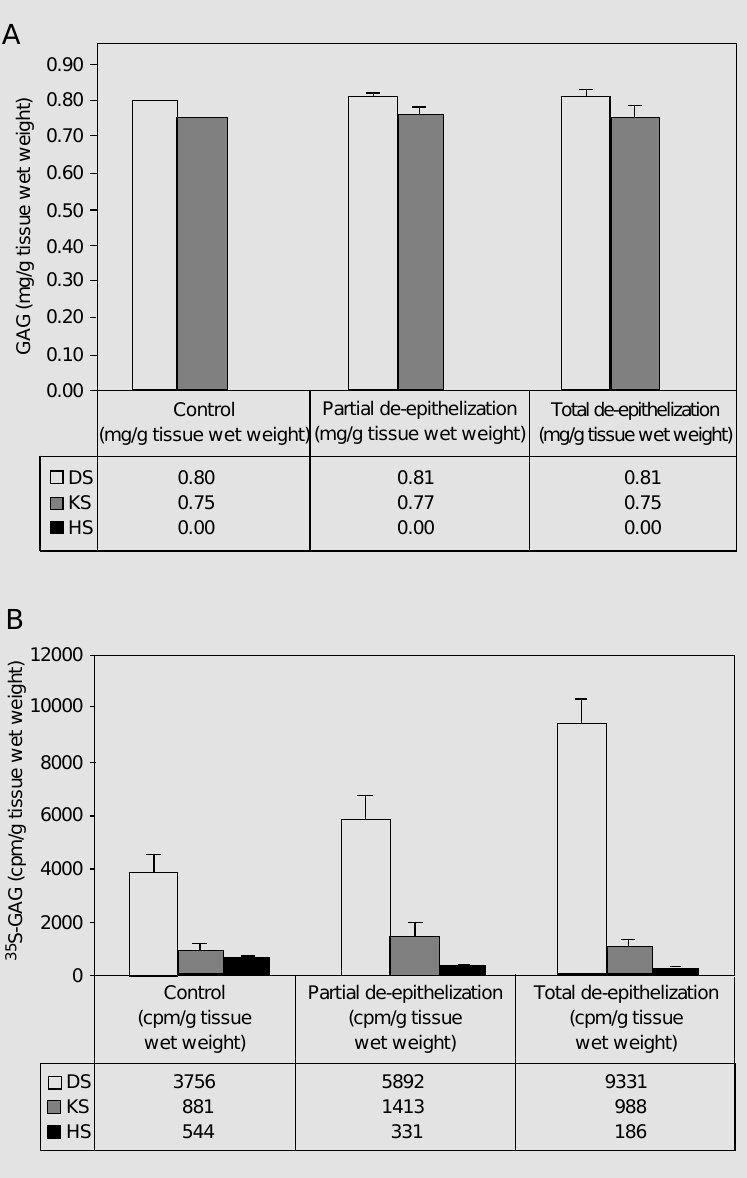
Figure 2 - Total glycosaminoglycans (A) and 35 S-labeled glycosaminoglycans (B) extracted from explants of intact or epithelium-debrided human corneas. Total glycosaminoglycans were stained with toluidine blue and quantified by densitometry. The 35 S-glycosaminogly- cans were visualized by radioautography and scraped off the gels, and radioactivity was measured with a liquid scintillation spectrophotometer. Data are reported as means ± SD of 14 experiments. GAG, Total glycosaminoglycan; DS, dermatan sulfate; KS, keratan sulfate; HS, heparan